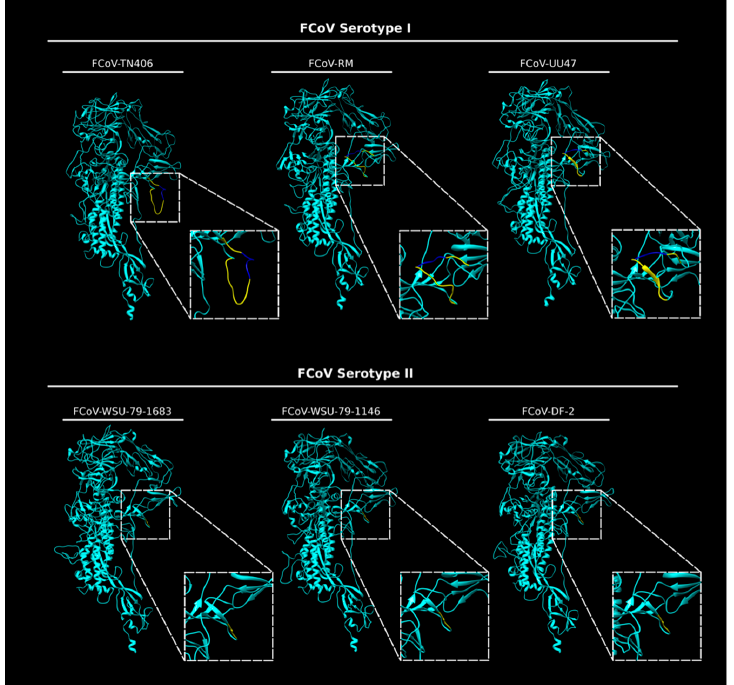
Figure 4. In silico modeling of the S protein from FCoV I and FCoV II strains. In silico FCoV S models of three FCoV type I strains (FCoV-RM, FCoV-UU47 and FCoV-TN406) and three FCoV type II strains (FCoV-DF-2, FCoV-WSU-79-1683 and FCoV-WSU-79-1146) were built using Chimera (UCSF Chimera v. 1.13.1, University of California). The S1/S2 region (dashed squares) was magnified to better visualize the differences between the two serotypes. The 16 amino acid insertion corresponding to the S1/S2 site (bright blue) and the 10 amino acid flanking region (yellow) were predicted as a flexible loop only in the FCoV type I S models.